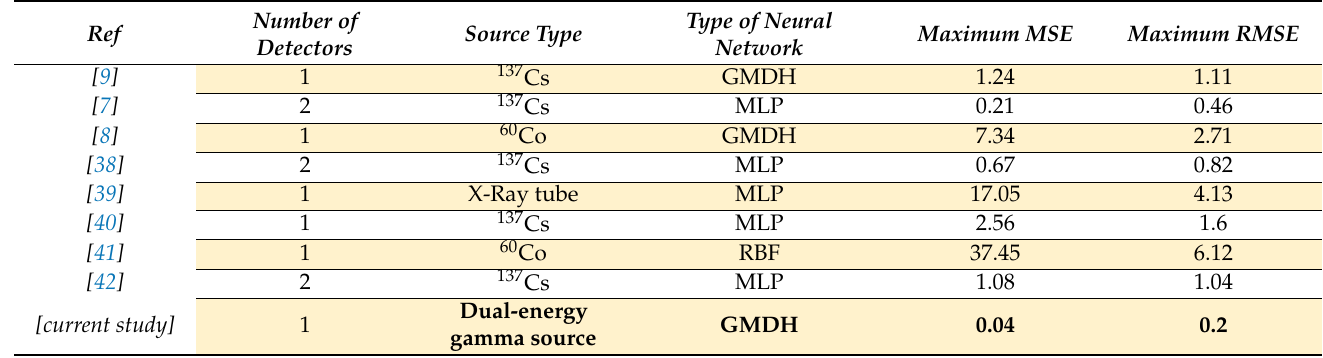
Table 2. A comparison of the accuracy of the proposed detection system and previous